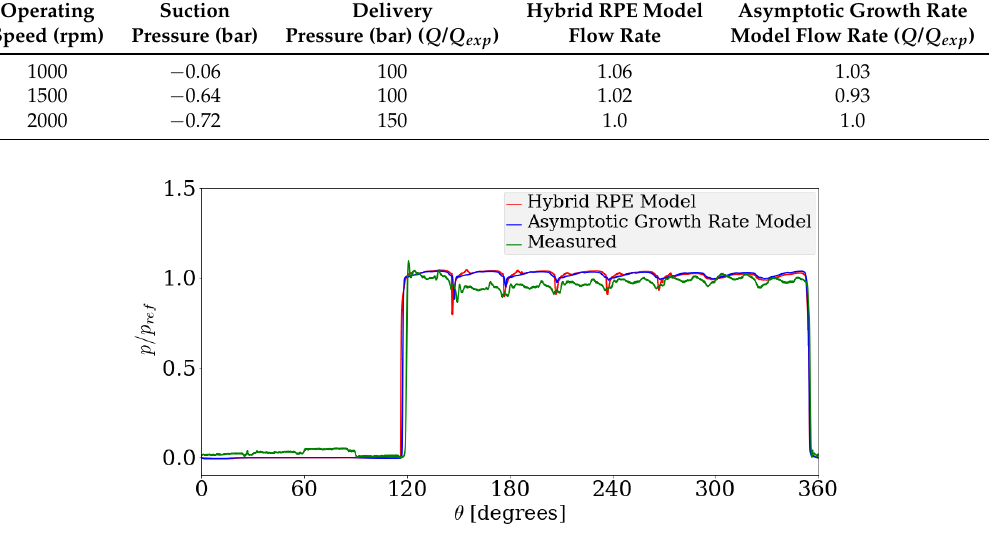
Figure 16. Comparison between instantaneous TSV pressure profiles for the Asymptotic Growth Rate model, Hybrid Rayleigh–Plesset solution approach with experimental data for 1000 rpm speed and suction pressure of − 0.06 bar gauge